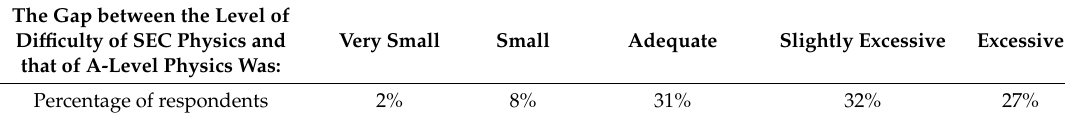
Table 2. Students on the disparity between SEC and AM